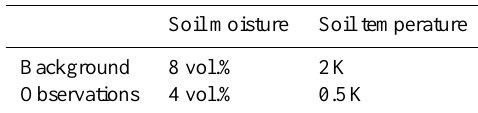
Table 2. Error estimates in the assimilation run for measurement site